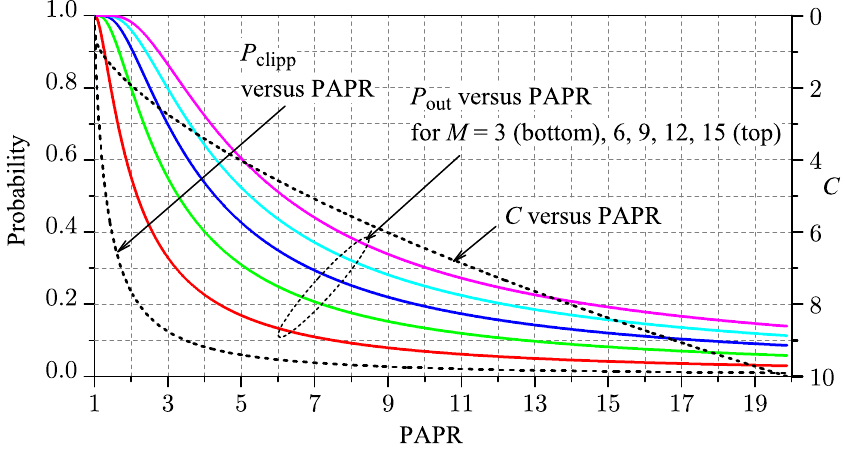
versus PAPR for 0 < C < 10 , M = 3 , E and P clipp out